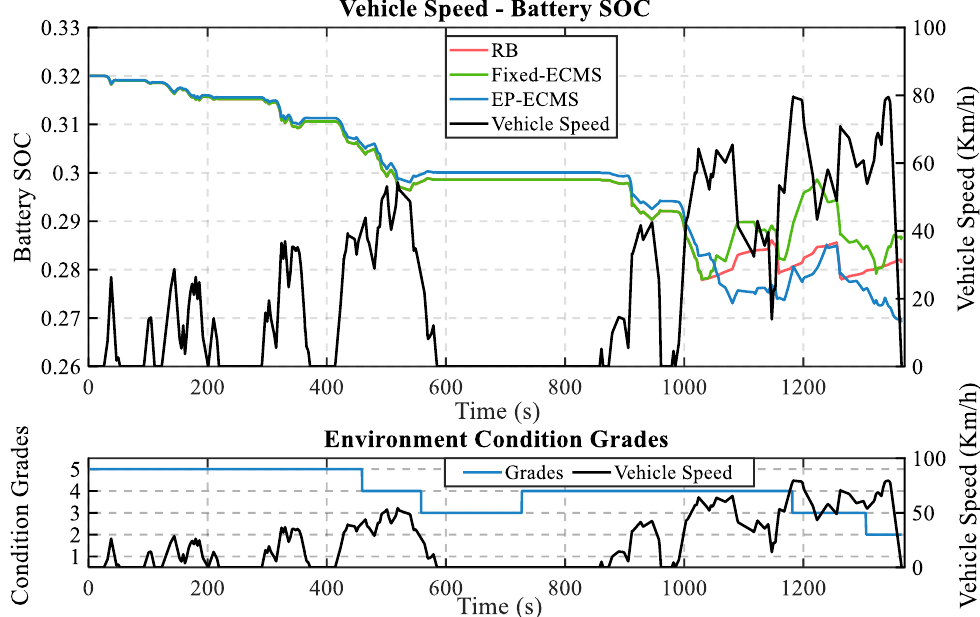
Figure 12. The second random working condition test